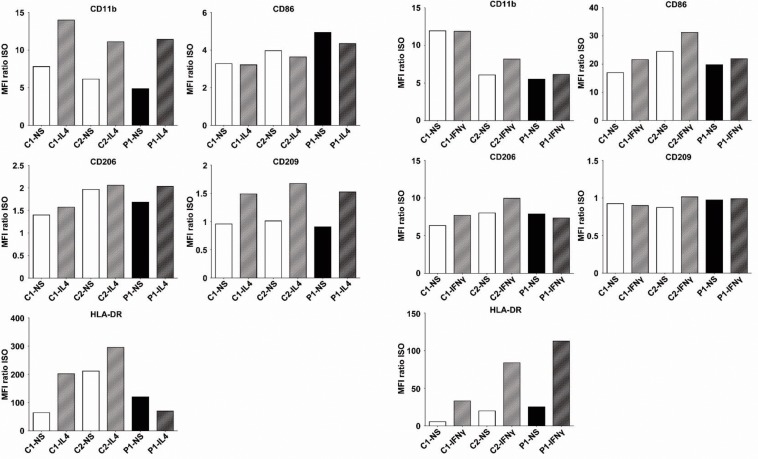
Surface marker levels in controls and patient monocyte-derived macrophages.CD11b, CD86, CD206, CD209 and HLA-DR mean fluorescence intensity (MFI) for M2-MDM (left) and M1-MDM (right) from P1 and two healthy unrelated controls (C1 and C2), either left non-stimulated (NS) or stimulated with IL-4 (for M2-like MDMs) or IFN-g (for M1-like MDMs). We showed that CD11b, CD86, CD206, CD209, and HLA-DR expression levels were similar in MDMs from P1 and healthy unrelated controls.